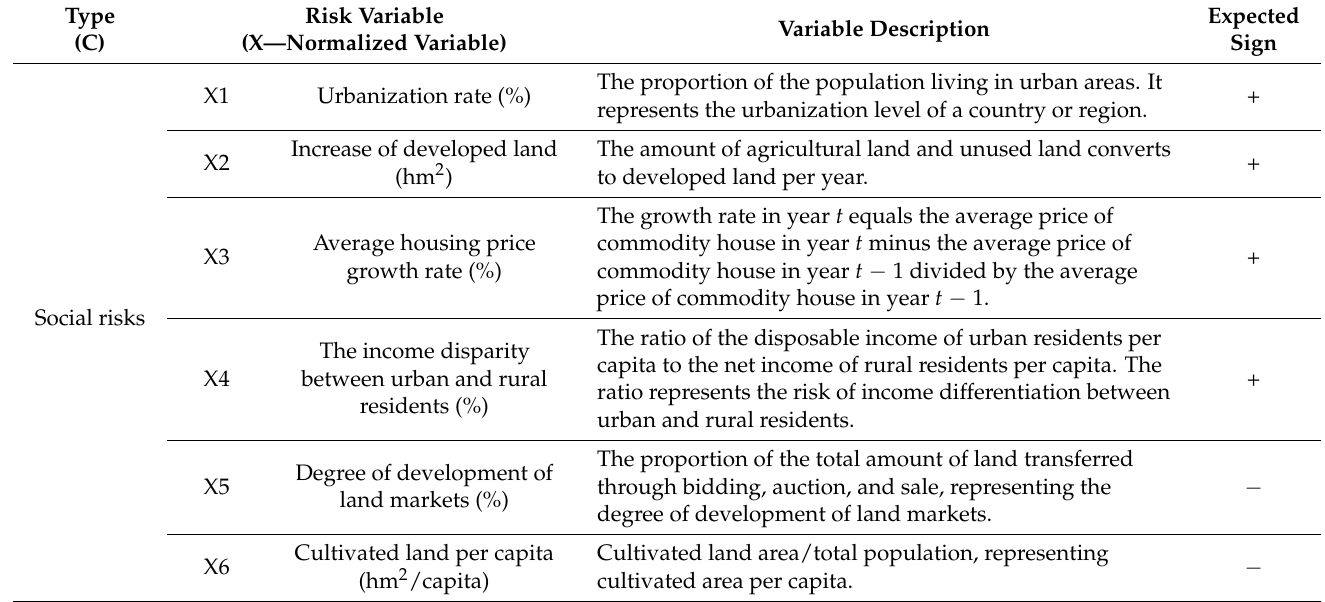
Figure 3. The four-dimensional risk matrix of land finance. Table 1. Selected indicators for land finance risks assessment based on the four-dimensional risk matrix.